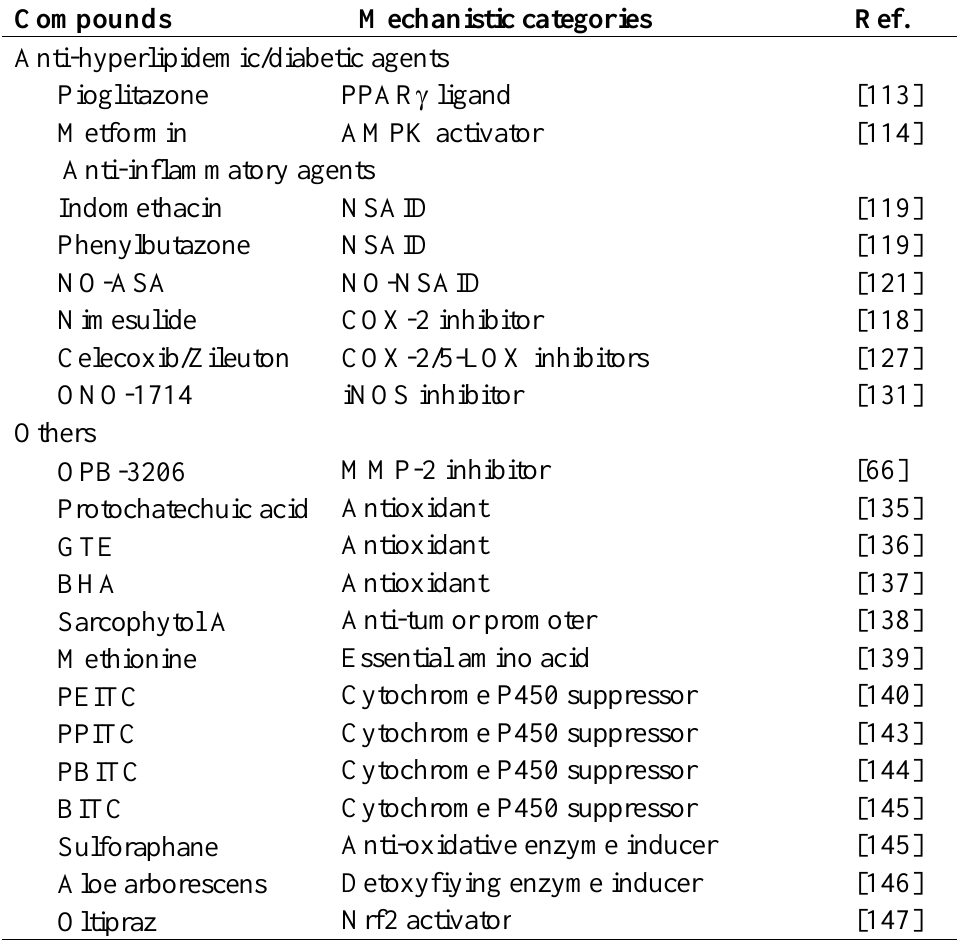
Table 2. Chemopreventive agents of N -nitrosobis(2-oxopropyl)amine (BOP)-induced pancreatic carcinogenesis in